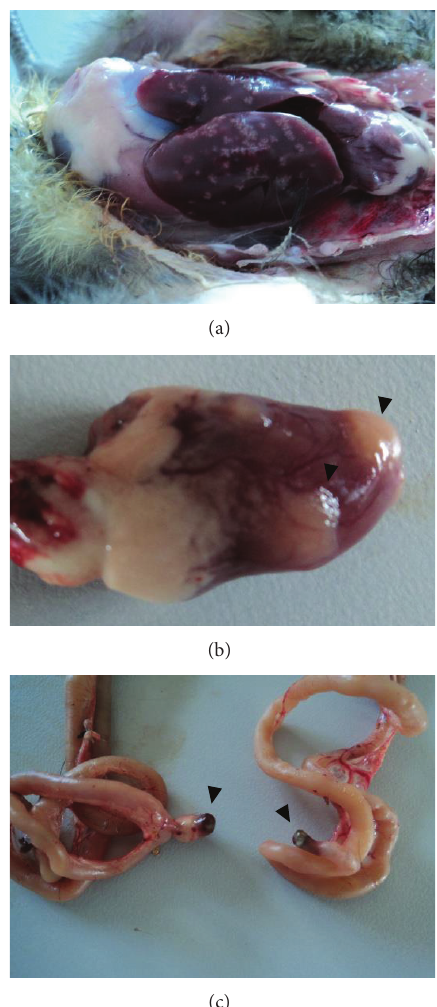
Figure 1: Liver (a), heart (b), and Meckel’s diverticulum of chick showing suggestive areas of necrosis (arrows) after the administra- tion of 25 mg/kg of Rhinella jimi